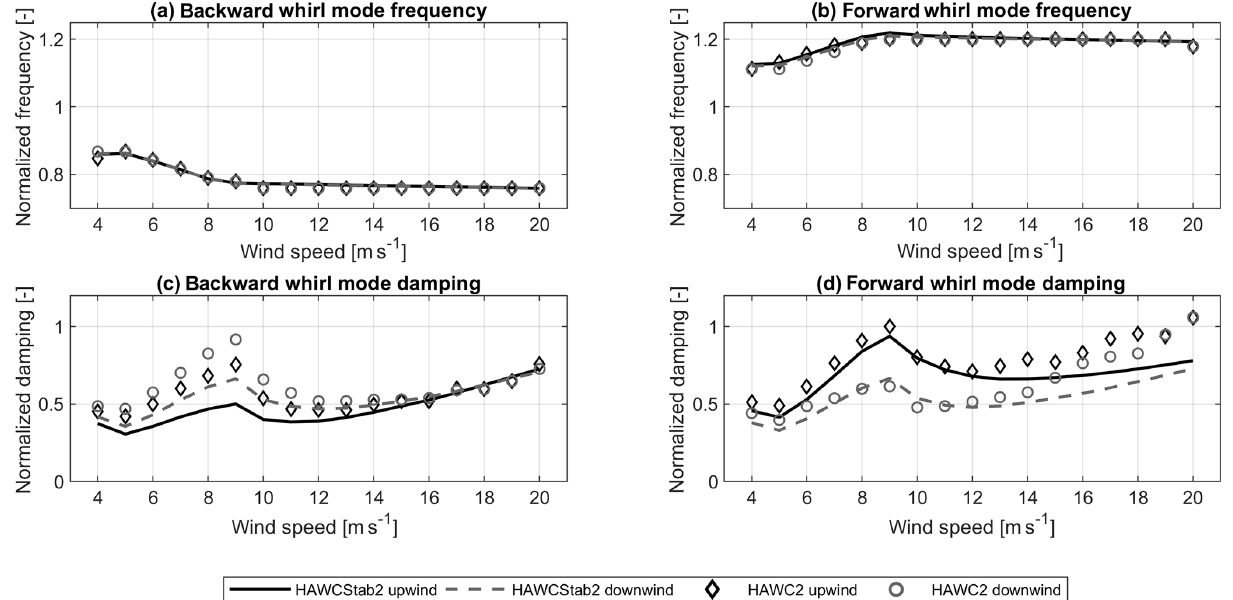
Figure 3. Normalized edgewise frequencies for the back whirl mode (a) and the forward whirl mode (b) for the upwind FF and the downwind FF configurations, as well as the damping of the backward whirl mode (c) and the forward whirl mode (d) . The frequencies are normalized with the blade natural edgewise frequency, and the damping is normalized with the damping of the upwind FF configuration at 9ms − 1 of the forward whirl mode from the HAWC2